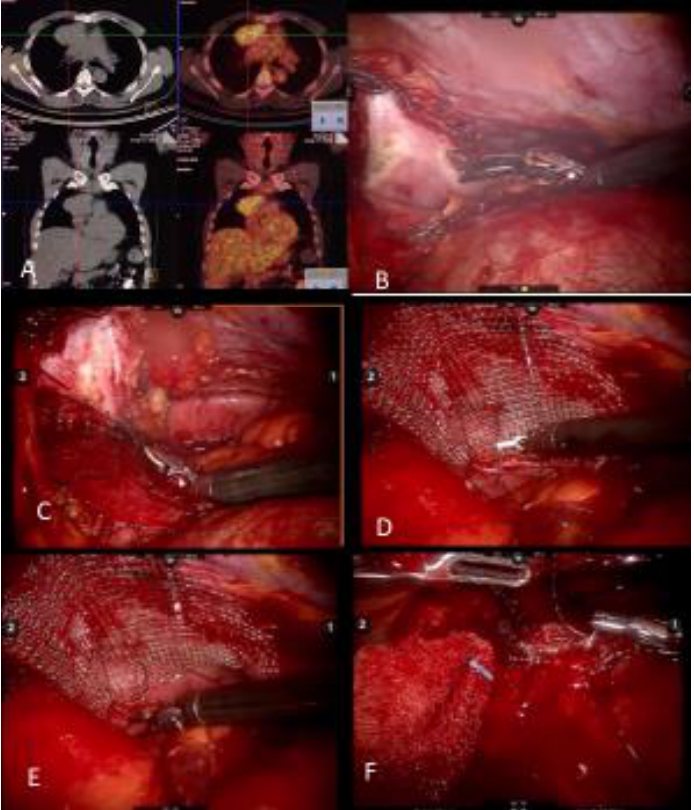
Figure 1. ( A ): Noncontrast CT of a myasthenia gravis patient with a thymoma and PET CT demon- strating FDG uptake. ( B ) Pericardial resection using the robotic bipolar instrument. ( C ) Invasion of pericardium may be deep in the left chest and may require upward traction up the pericardium. It is important to identify and preserve the left phrenic nerve from medial and internal side of the pericardium. ( D ) When reconstructing the pericardium with a graft, the first suture placed allows upward traction of the hilar pericardium. ( E ) A continuous suture technique with barbed sutures is preferred when reconstructing the pericardium. ( F ) As the left hilar pericardium is pulled up, attention should be given to not place the graft too tight as to constrict the heart.